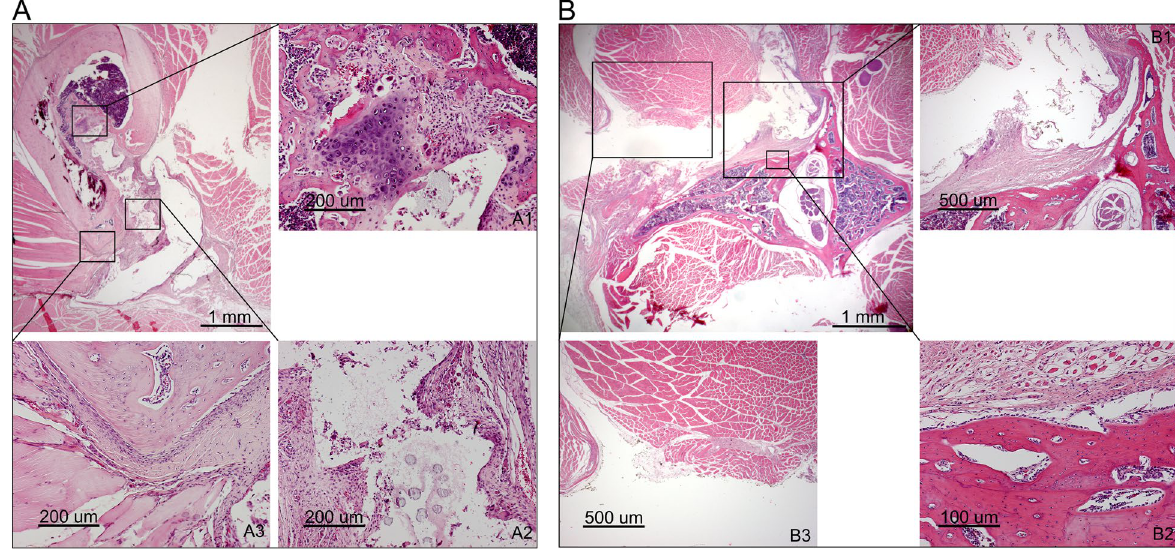
Fig. 2 Representative histology images. A Hematoxylin and eosin staining of a femoral implantation site with cartilaginous new bone formation in the screw trajectory (A1), fibrous capsule formation around the screw head (A2) and periosteal thickening (A3). B Hematoxylin and eosin staining of a spinal implantation site with fibrous capsule formation around the screw head (B1), abundant osteoblasts lining the cortex (B2) and muscle fibrosis